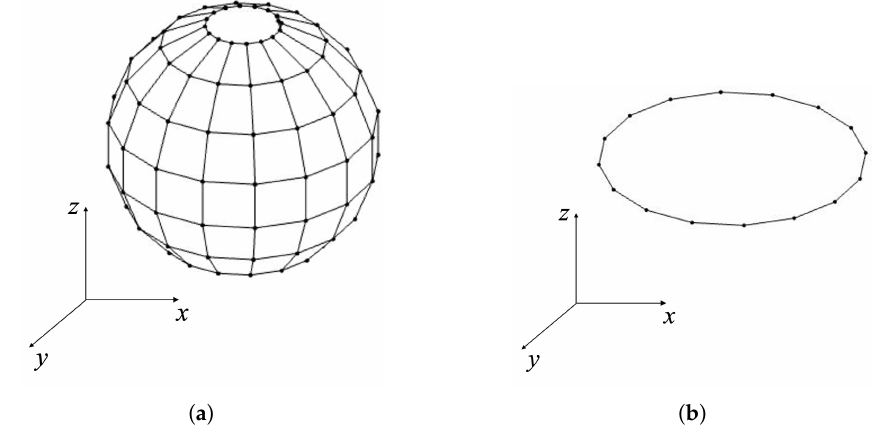
Figure 1. ( a ) Gaussian sampling grids for three-dimensional (3D) wave field information. ( b ) pro- posed circular array for two-dimensional (2D) wave field information when N = 8.